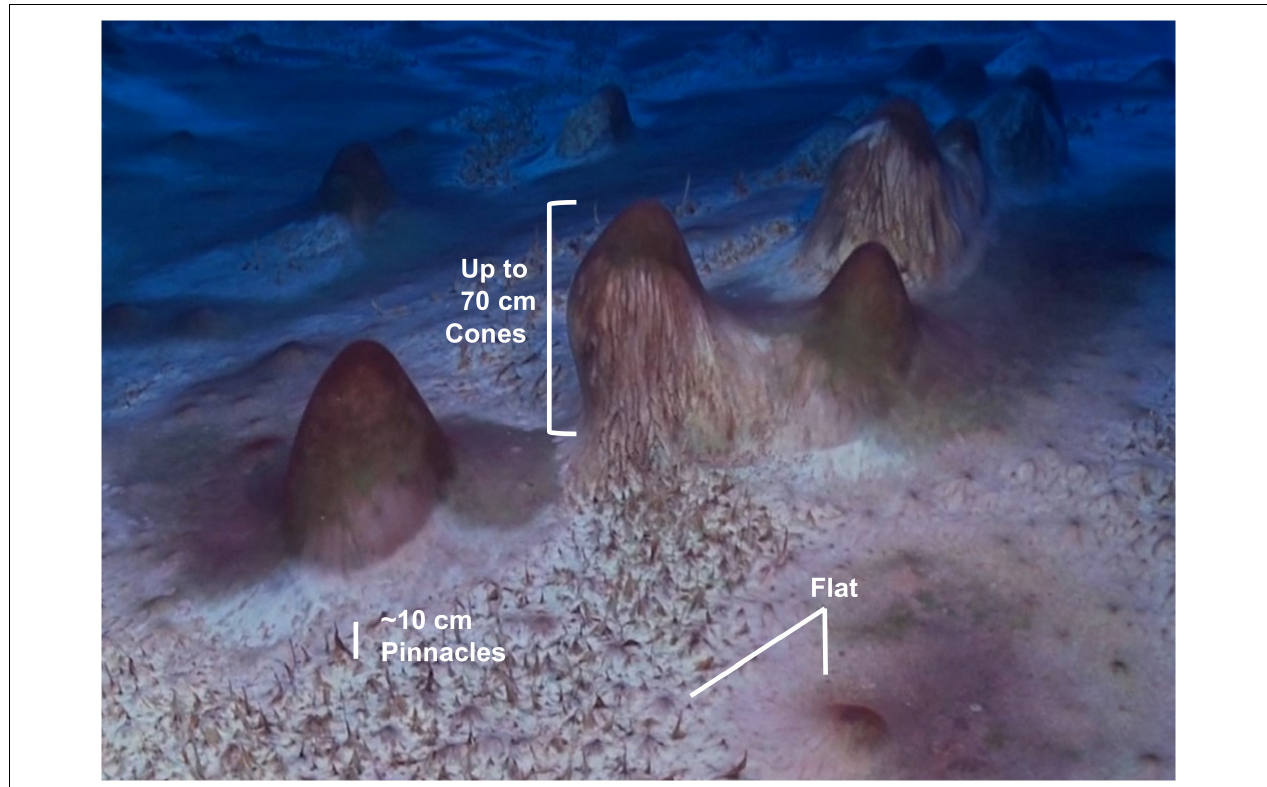
FIGURE 2 | Cones, pinnacles and flat cyanobacteria-based microbial mats with purple and green pigmentation due to phycoerythrin and chlorophyll, respectively, grow in the perennially ice-covered Lake Untersee, East Antarctica.